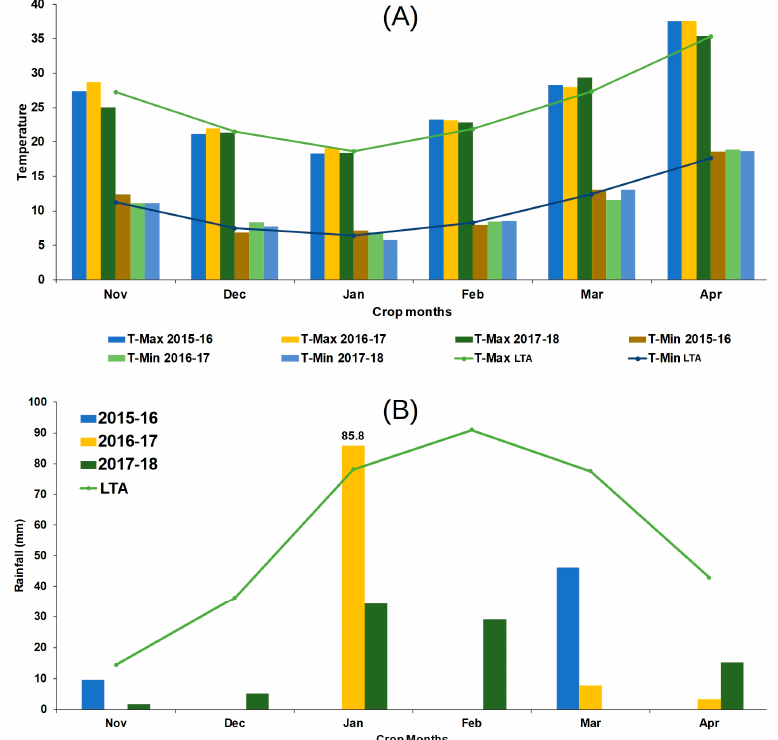
Figure 1. Monthly mean maximum and minimum temperature ( A ) and monthly total rainfall ( B ) at IIWBR, Karnal during experimental years compared with long-term averages (1972–2017).